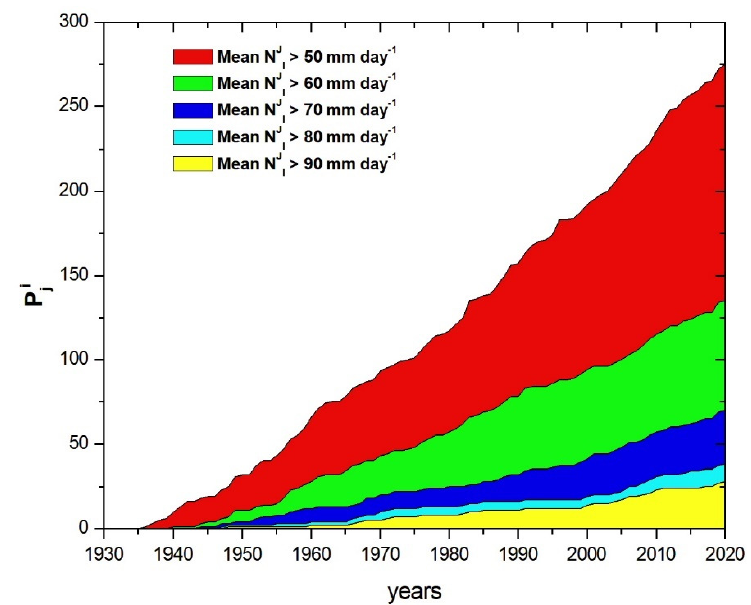
Figure 3. Annual evolution of accumulated days with rain above five thresholds. The colors used to indicate each threshold are the same as those used in Figure 1.